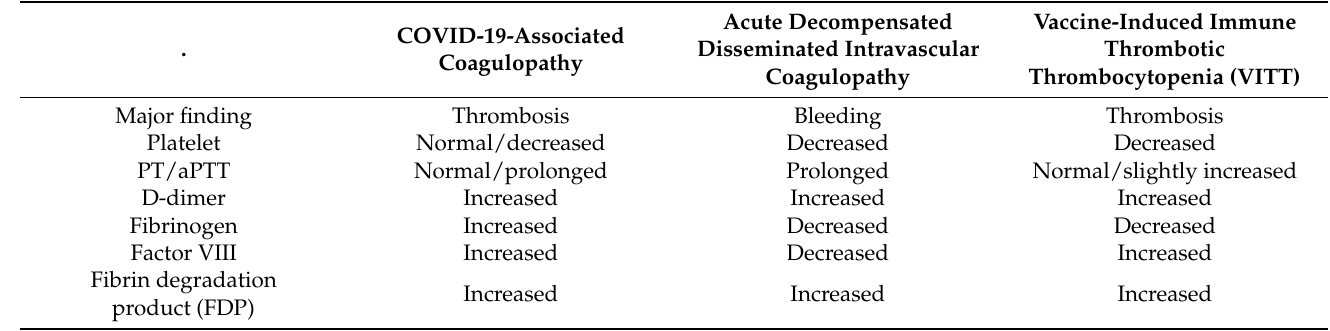
Table 1. Differences in laboratory results between COVID-19-associated coagulopathy and dissemi- nated intravascular